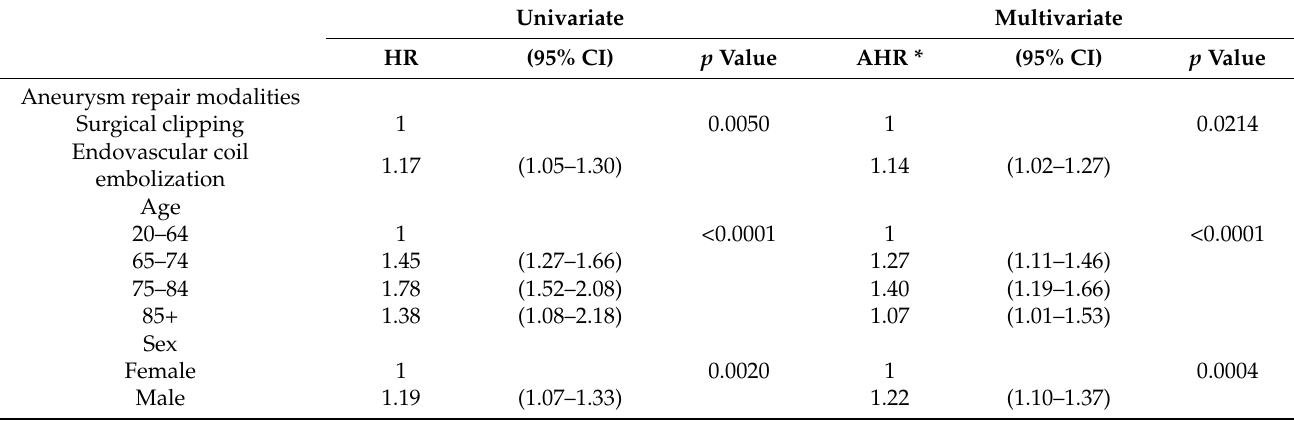
Table 2. Cox proportional hazards regression analysis of the risk of vasospasm among the propensity score-matched patients with ruptured subarachnoid aneurysm undergoing surgical clipping or endovascular